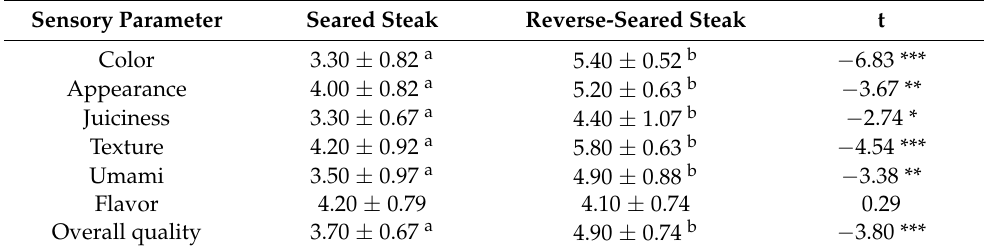
Table 5. Scores of sensory evaluations of seared and reverse-seared steaks. Sensory